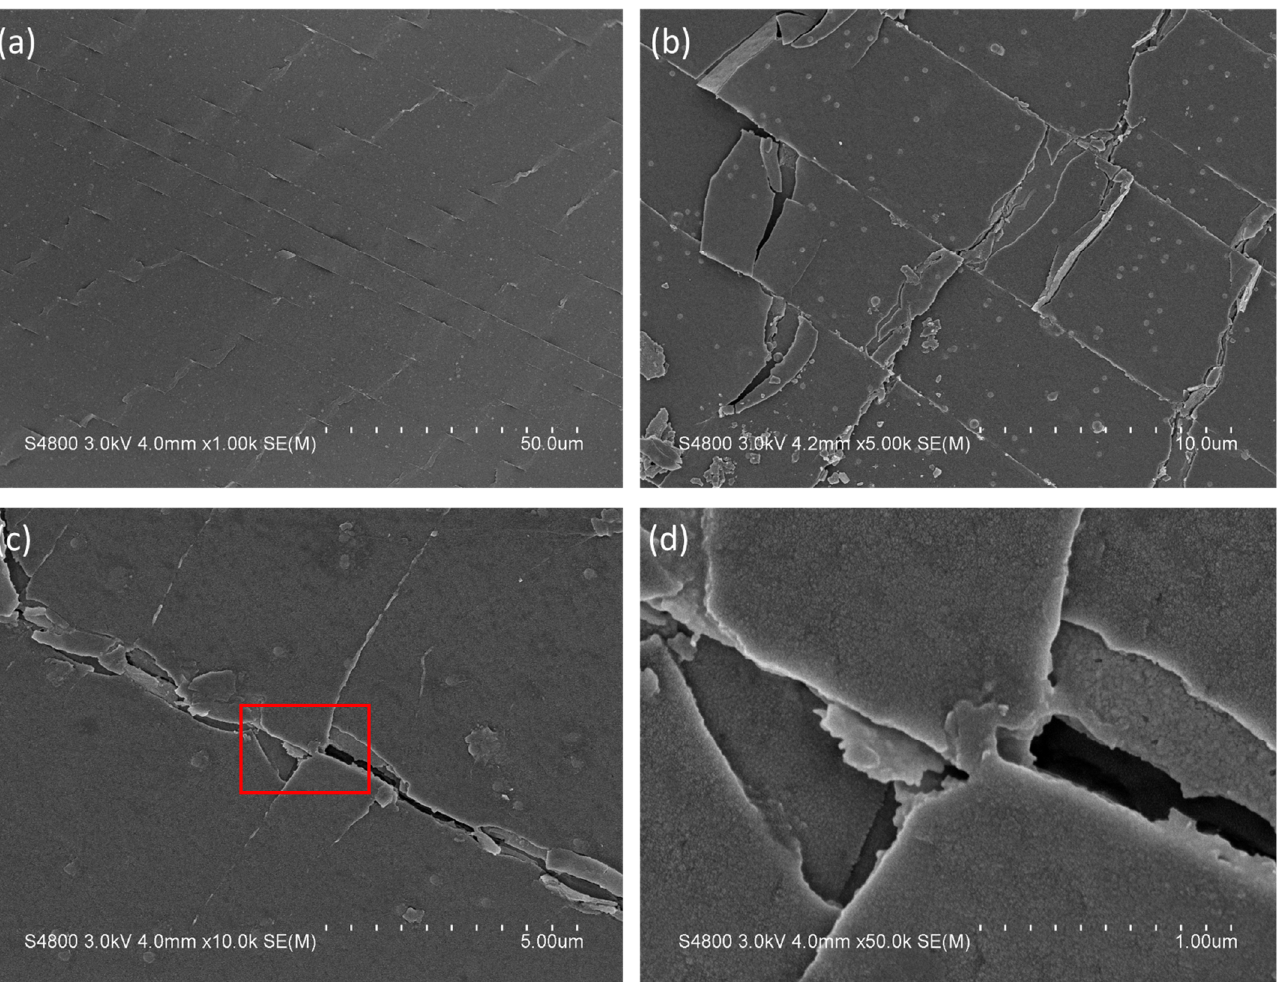
Figure 9. SEM images showing the tensile-stress-caused failure of OMO samples after cyclic bending: ( a ) unaged OMO sample; ( b ) low-magnification image of the 15 d aged OMO sample; ( c ) high-magnification image of the 15 d aged OMO sample; ( d ) zoom-in of the red rectangular area in ( c ).